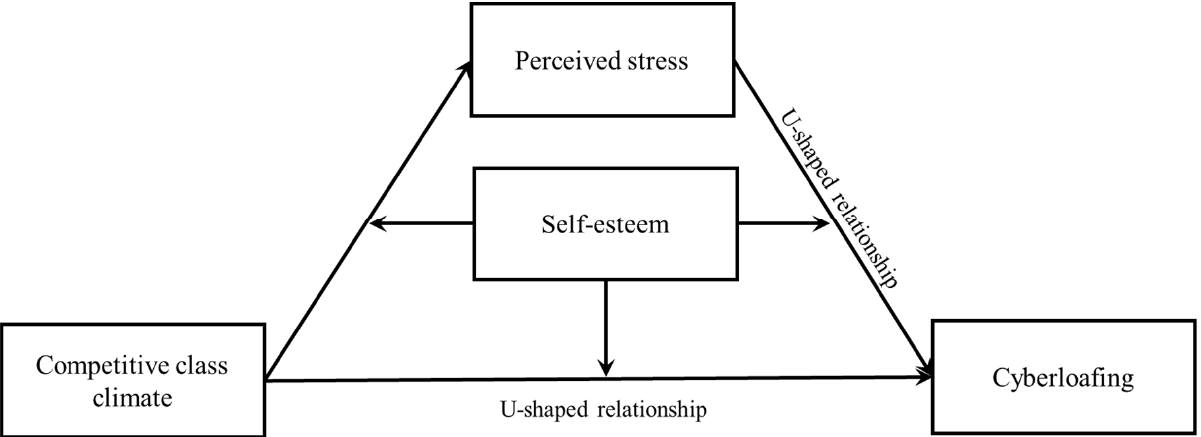
Figure 1. Hypothesized model.